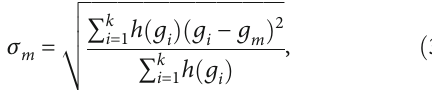
First, for denoising the image and preserving the edge